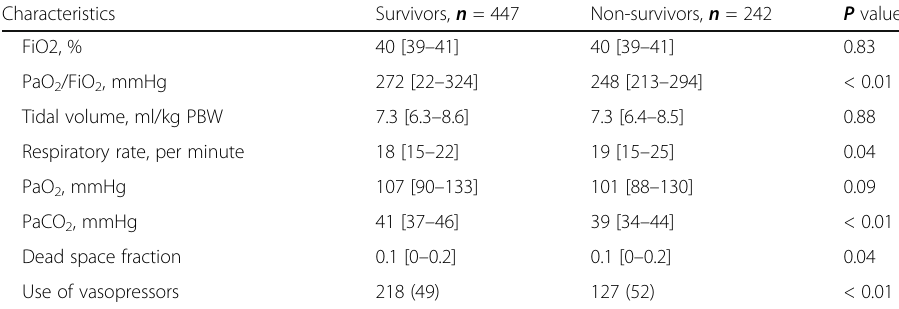
Table 1 Baseline characteristics of patients with mild hypoxemia who survived and patients who died in the hospital (Continued)